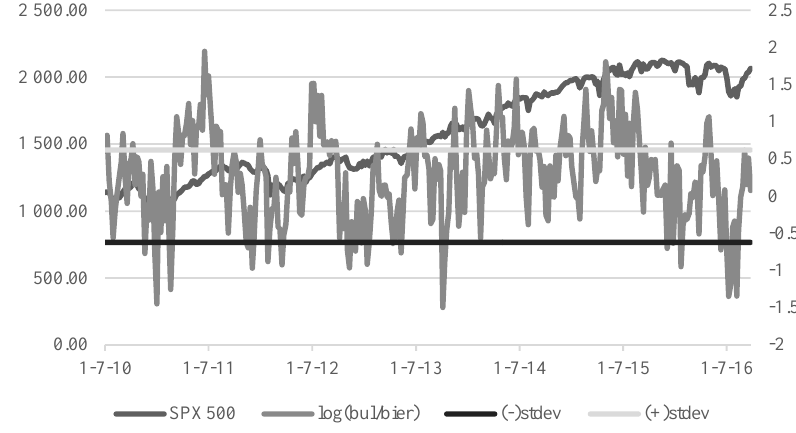
Figure 3 . Dynamic of historical data for individual investors’ sentiments (AAII) and the SPX500